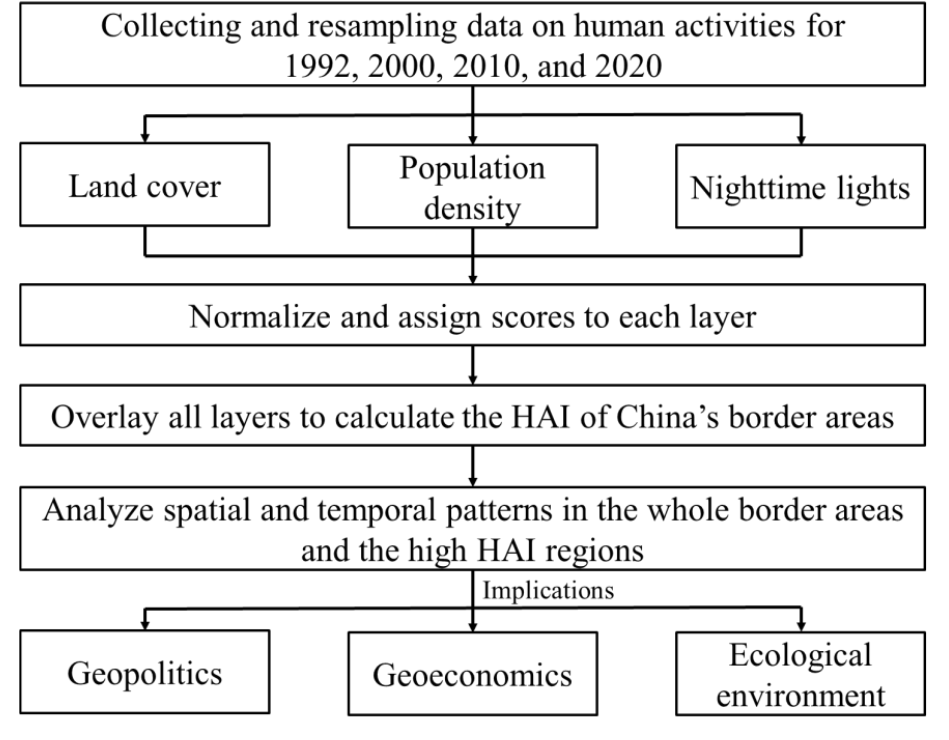
Figure 2. Flowchart of the methodology.